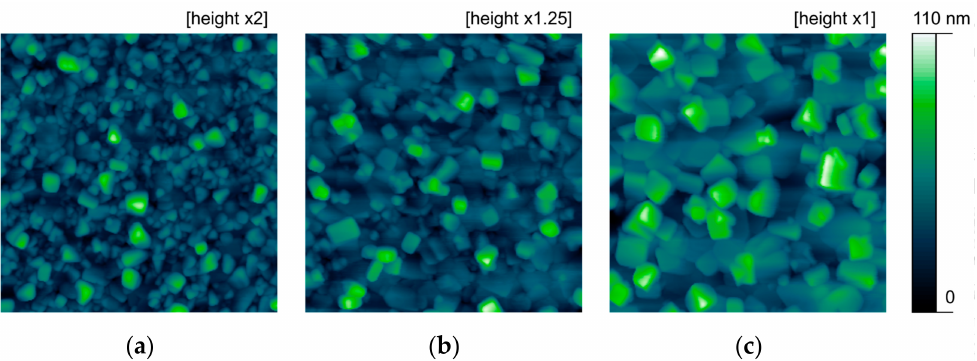
Figure 2. Representative AFM images of LiF films deposited on Si substrates at 150 ◦ C over a 1 × 1 µ m 2 area for a varying number of ALD cycles, with the corresponding effective thickness ( t ), and the rms roughness ( S q ) averaged over five spots on each sample: ( a ) 1300 cycles, t = 19 nm, S q = 6.8 ± 0.3 nm; ( b ) 2500 cycles, t = 33 nm, S q = 11.5 ± 0.3 nm; ( c ) 5000 cycles, t = 56 nm, S q = 18.7 ± 1.7